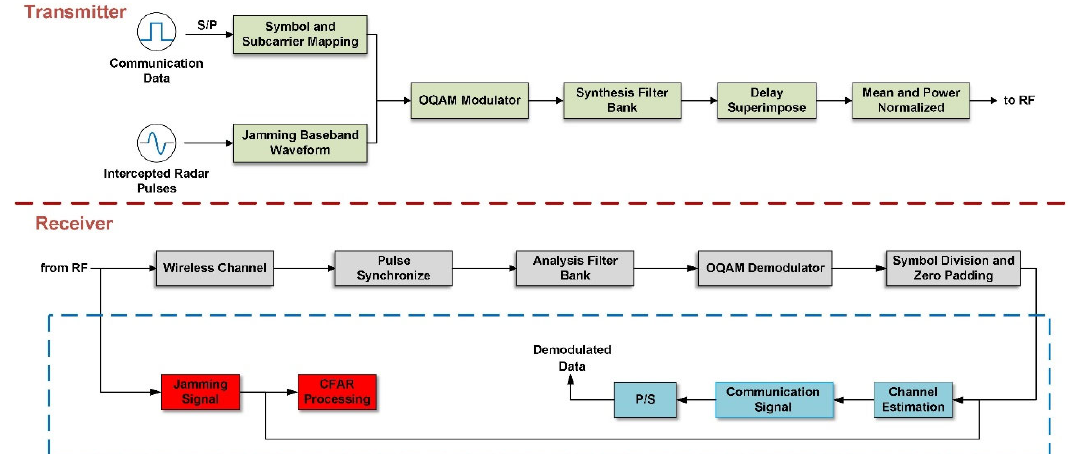
Figure 5. Joint communication and jamming system flow based on FBMC chirp signal.